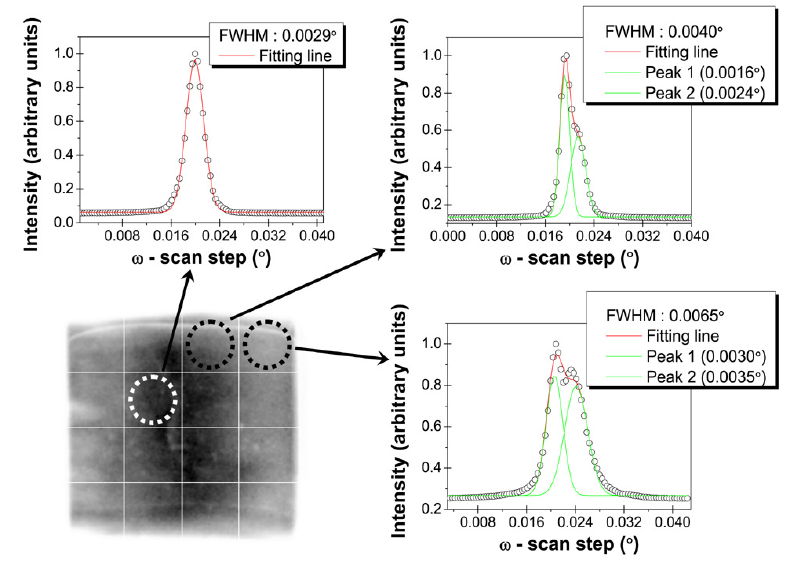
Figure 2. Typical XRD rocking-curve for a tetragonal HEW lysozyme crystal grown under application of an external electric field at 1 MHz. These XRD rocking-curves were obtained for the 440 reflection. Profiles were acquired using a beam spot diameter of 387 µ m (60 pixels). Reproduced from reference [19], with the permission of AIP